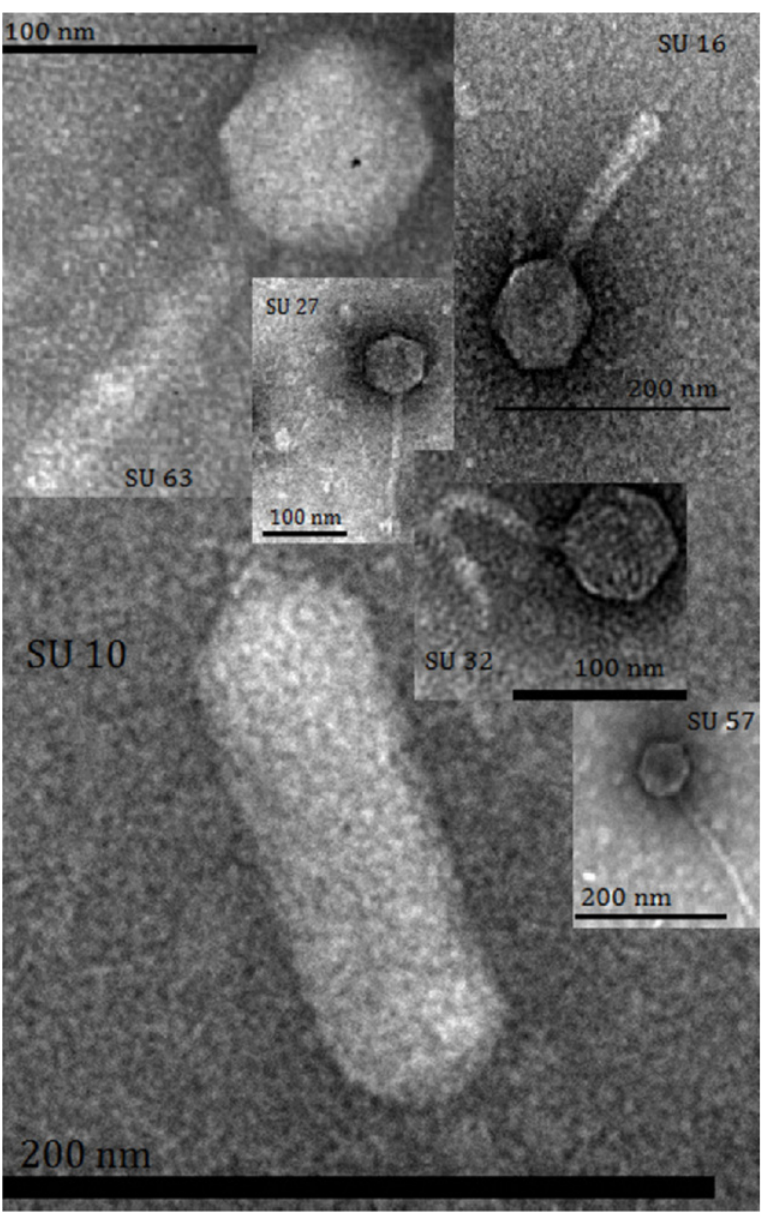
Fig 1. Transmission electron micrographs of the six phages in this